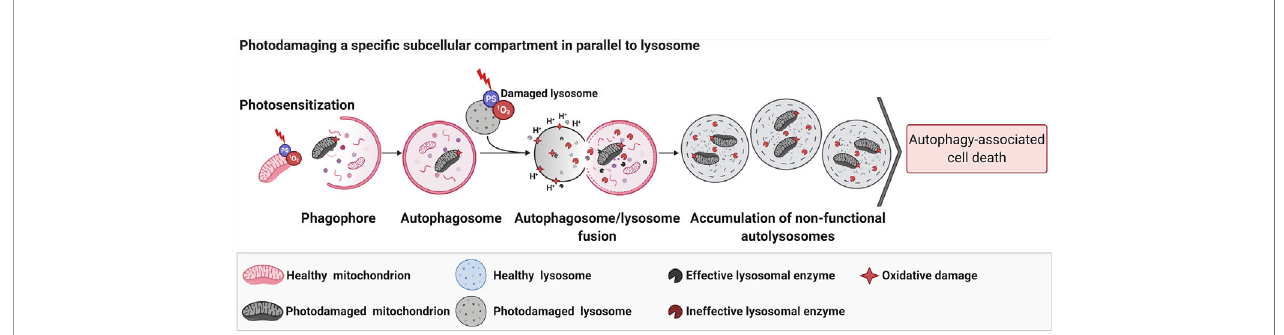
FIGURE 5 | Parallel photodamage in mitochondria and lysosome evolves to autophagy-associated cell death. The PDT-mediated photodamage in mitochondria and lysosomes per si leads to ef fi cient autophagy-associated cell death regardless of the chemical modulation of autophagy fl ux (i.e., BAF-A1 or 3-MA) (59). Figure created